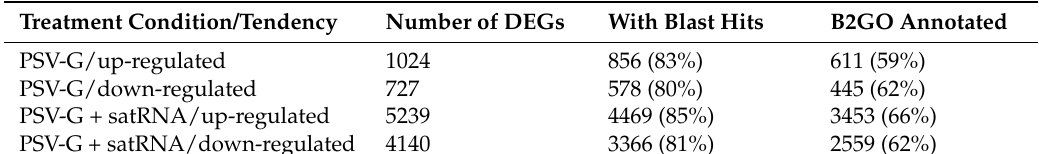
Table 1. Differentially expressed genes (DEGs) of Nicotiana benthamiana infected with PSV-G or PSV-G + satRNA. Percentage of DEGs with Blast hits and percentage annotated DEGs using the Blast2Go Pro server are shown.